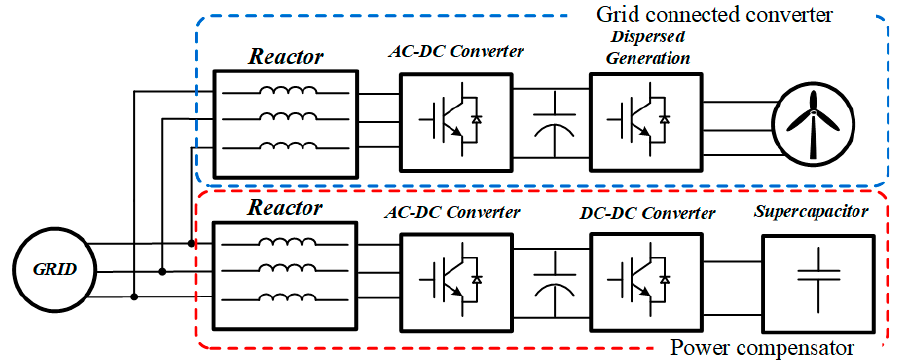
Figure 4. Full block diagram of power compensators and grid-connected devices.